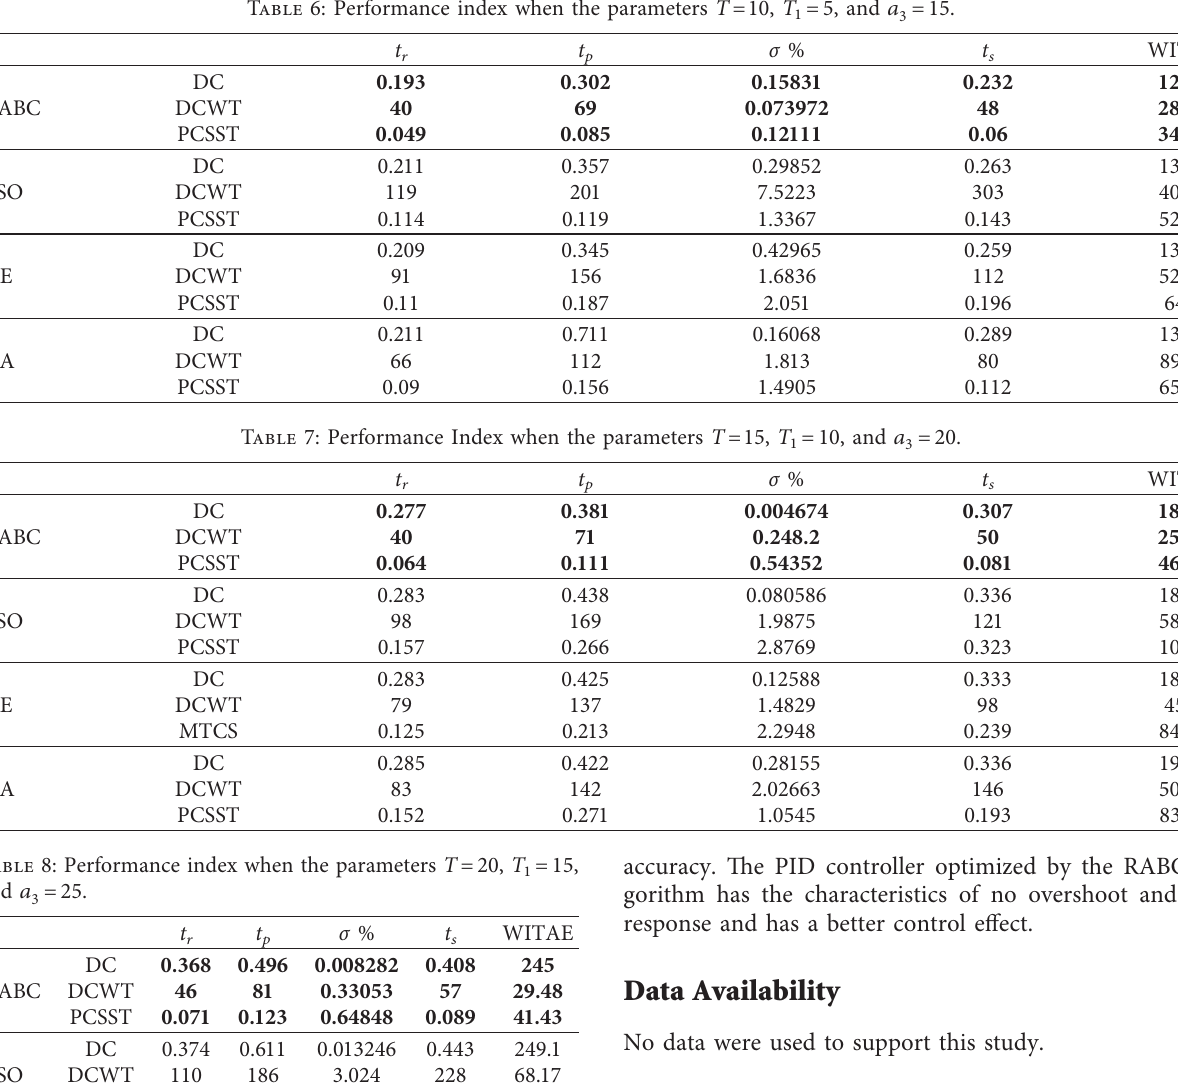
Table 6: Performance index when the parameters T � 10, T